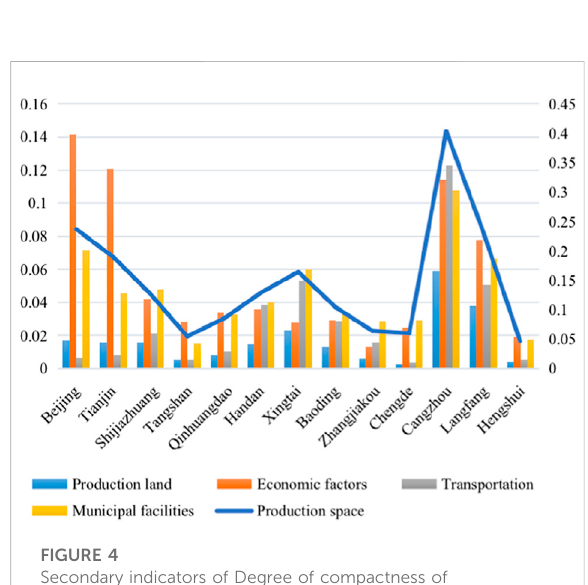
FIGURE 3 Degree of Compactness of production space in Beijing-